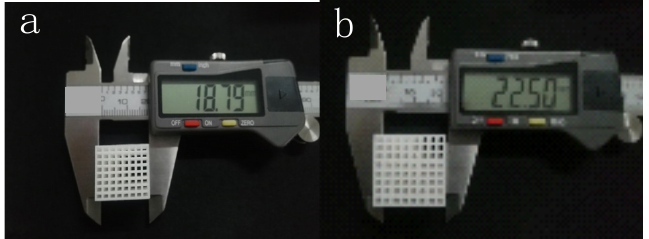
Figure 7. The 3D printed objects of model 3. ( a ) Model 3, m = 2.5; ( b ) model 3, m = 3.